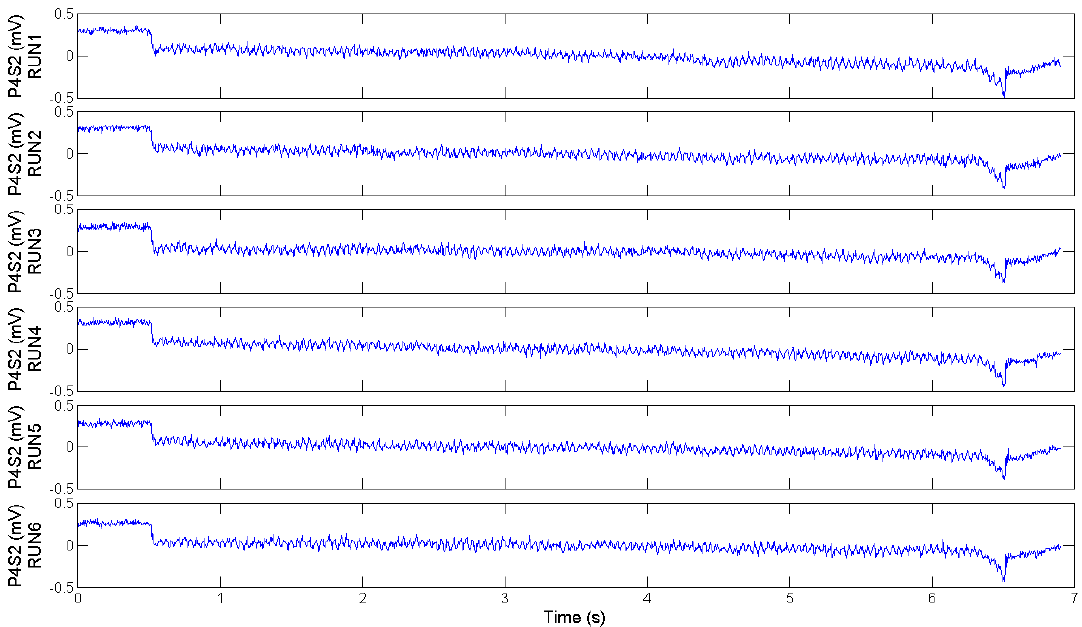
Figure 6. Outputs from P4S2 of the fingertip b with curved fingerprints, over six runs under the same experimental conditions ( Δ p repeatability of experimental data.